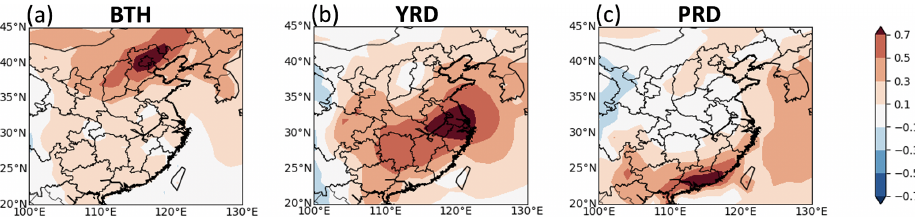
Figure 2. Correlation coefficients of daily mean PM 2 . 5 concentrations over all UKESM1 grid cells with those in the grid cells covering (a) Beijing, (b) Shanghai, and (c) Guangzhou during DJF 1999–2018. Regions where correlations are higher than 0.7 (dark red shading) are selected to represent the Beijing–Tianjin–Hebei (BTH), Yangtze River delta (YRD), and Pearl River delta (PRD) regions.